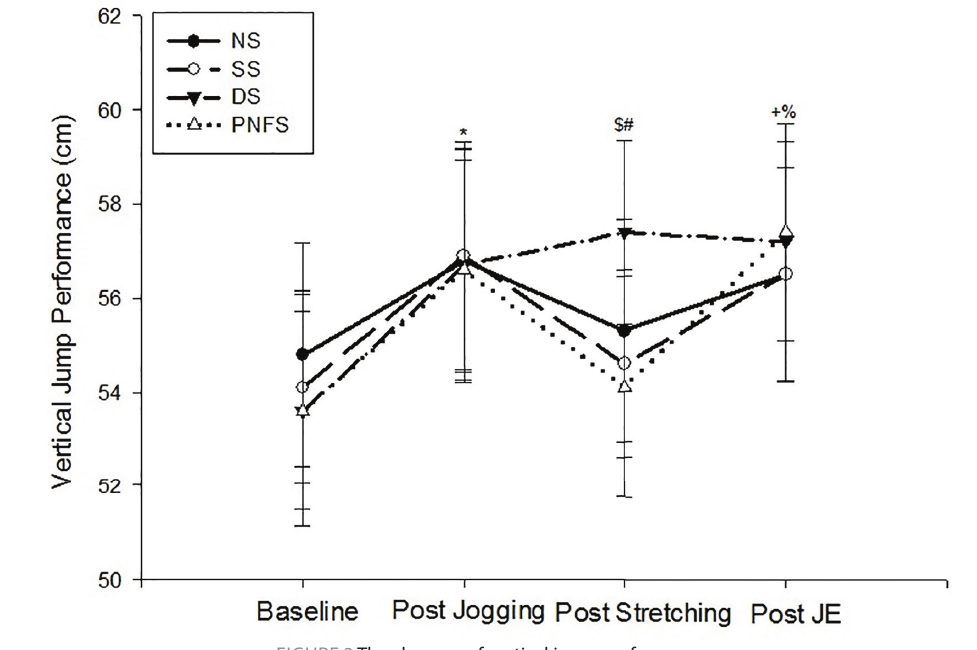
FIGURE 3 The changes of vertical jump